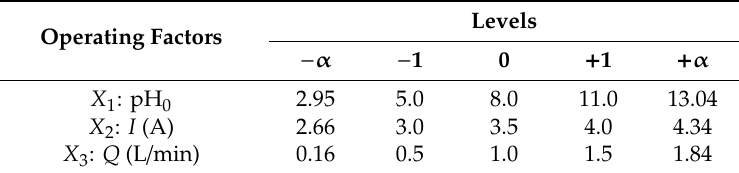
Table 3. Values and levels of operating parameters.